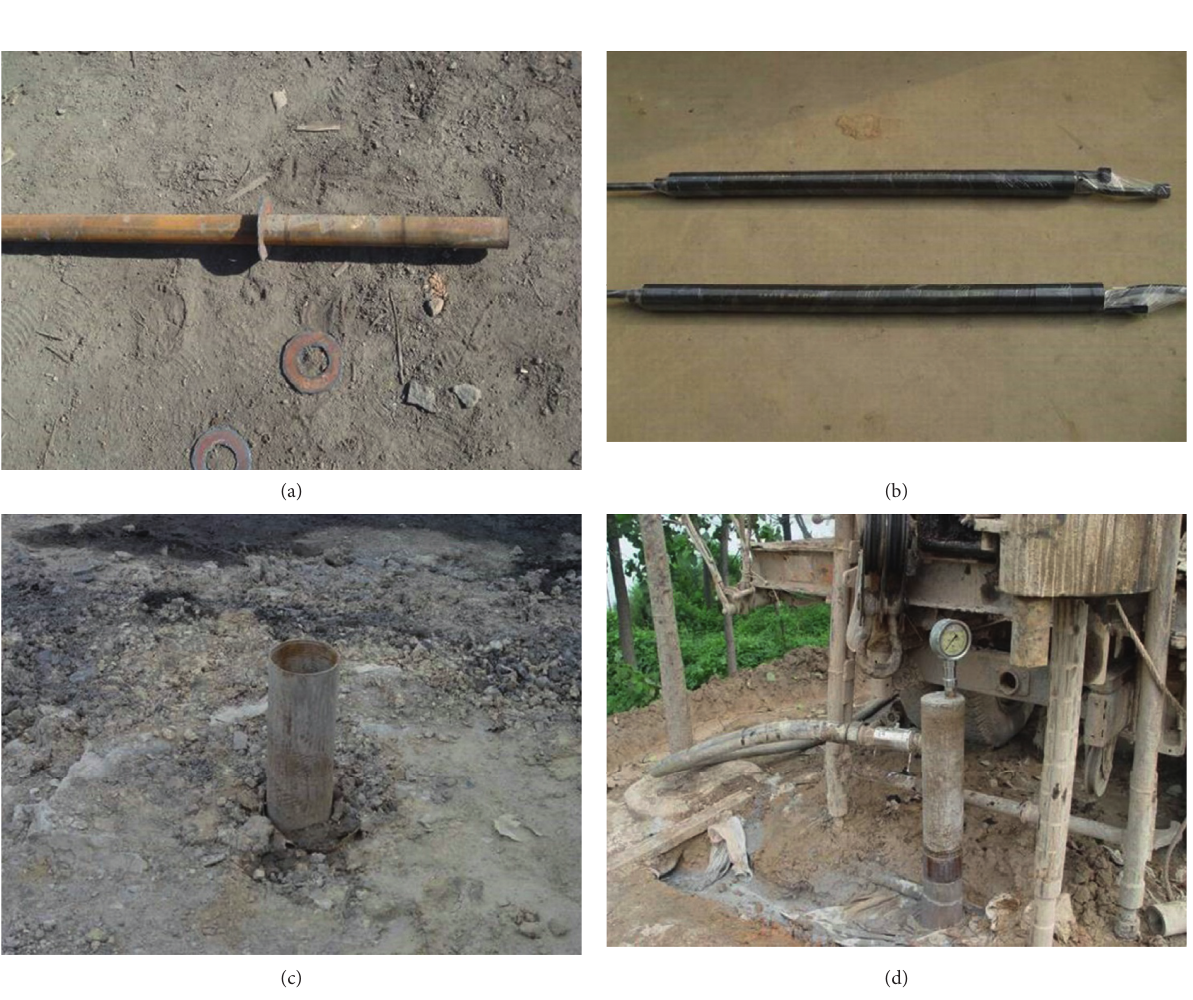
Figure 18: (a) Simple flange slurry stopping device. (b) DMP-91 capsule type. (c) Casing sealing. (d) Casing upper three-way conversion